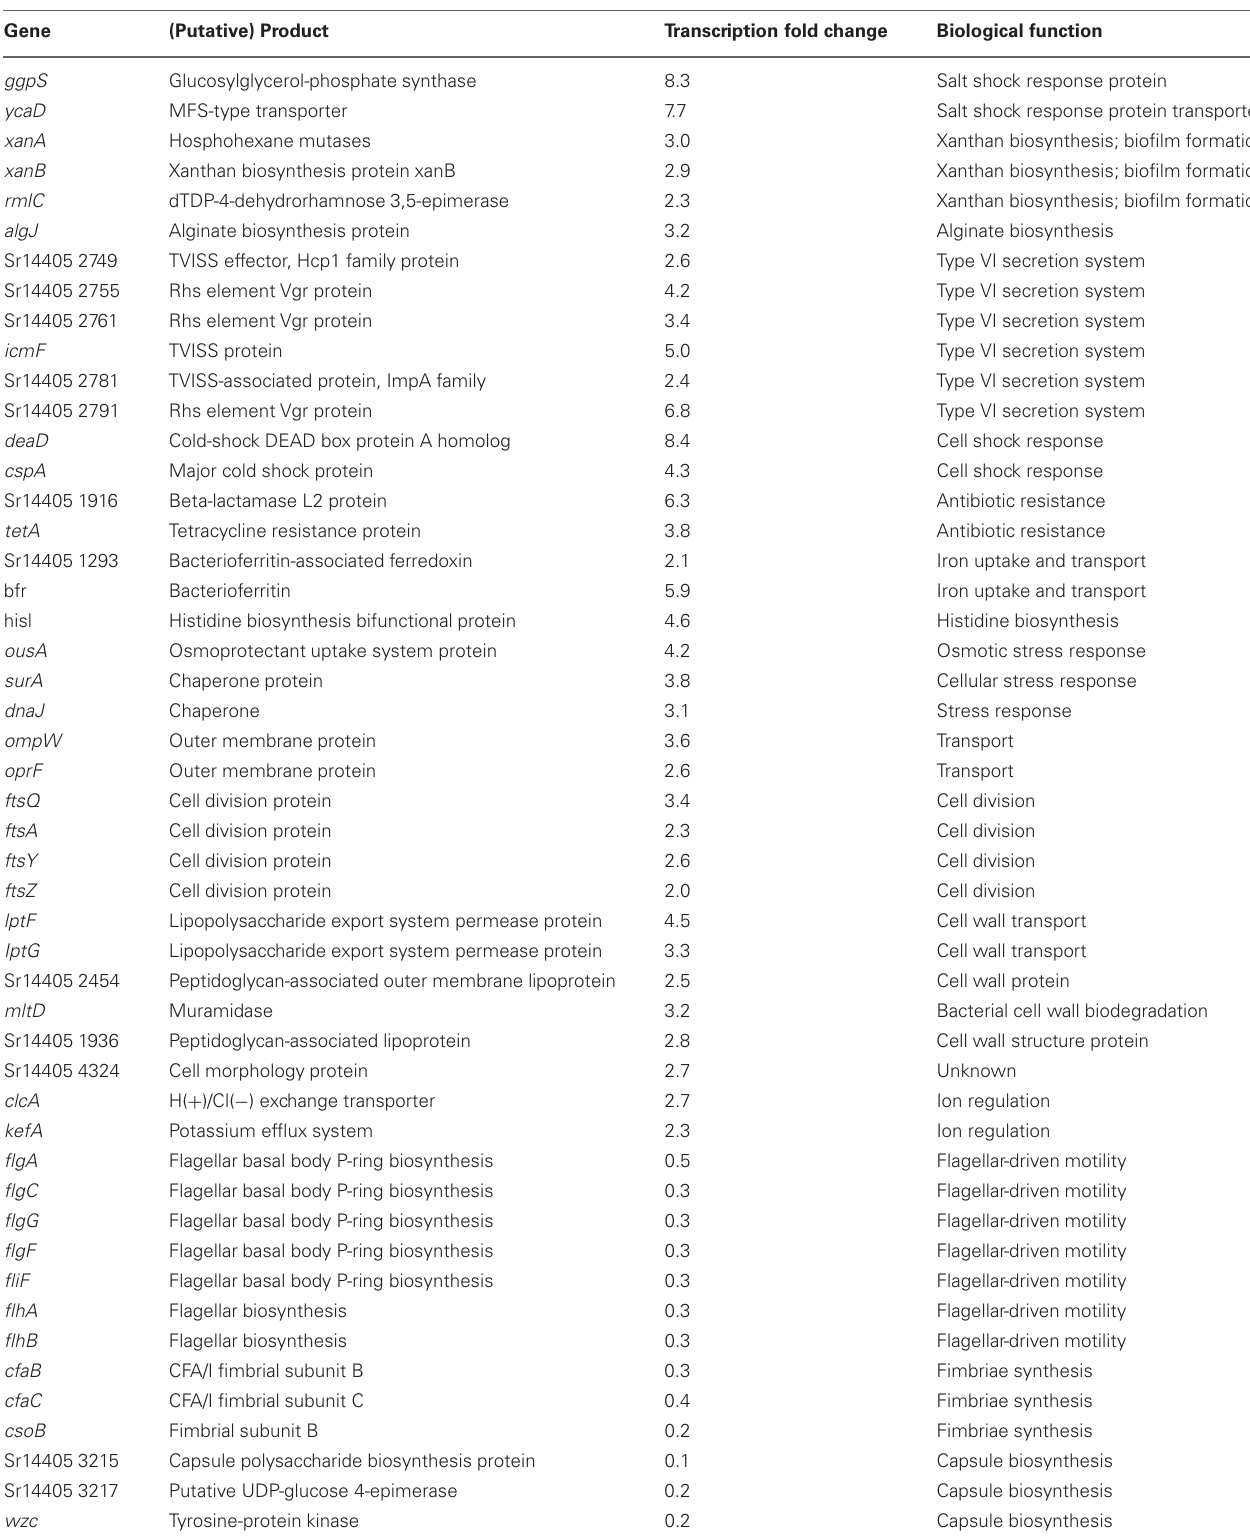
Table 1 | Selected S. rhizophila DSM14405 T genes with known biological roles impacted by salt shock.